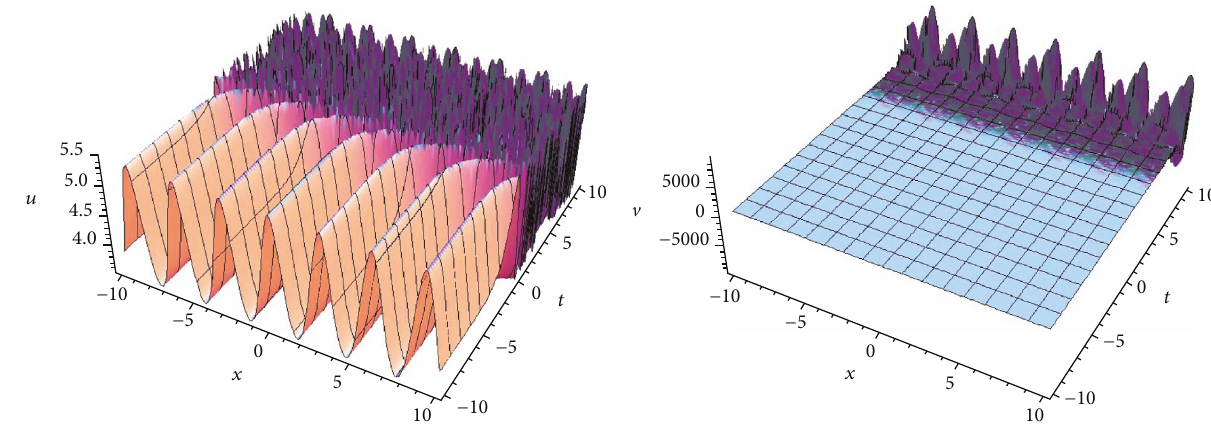
Figure 5: Spatial structures of solutions (27) determined by (52).